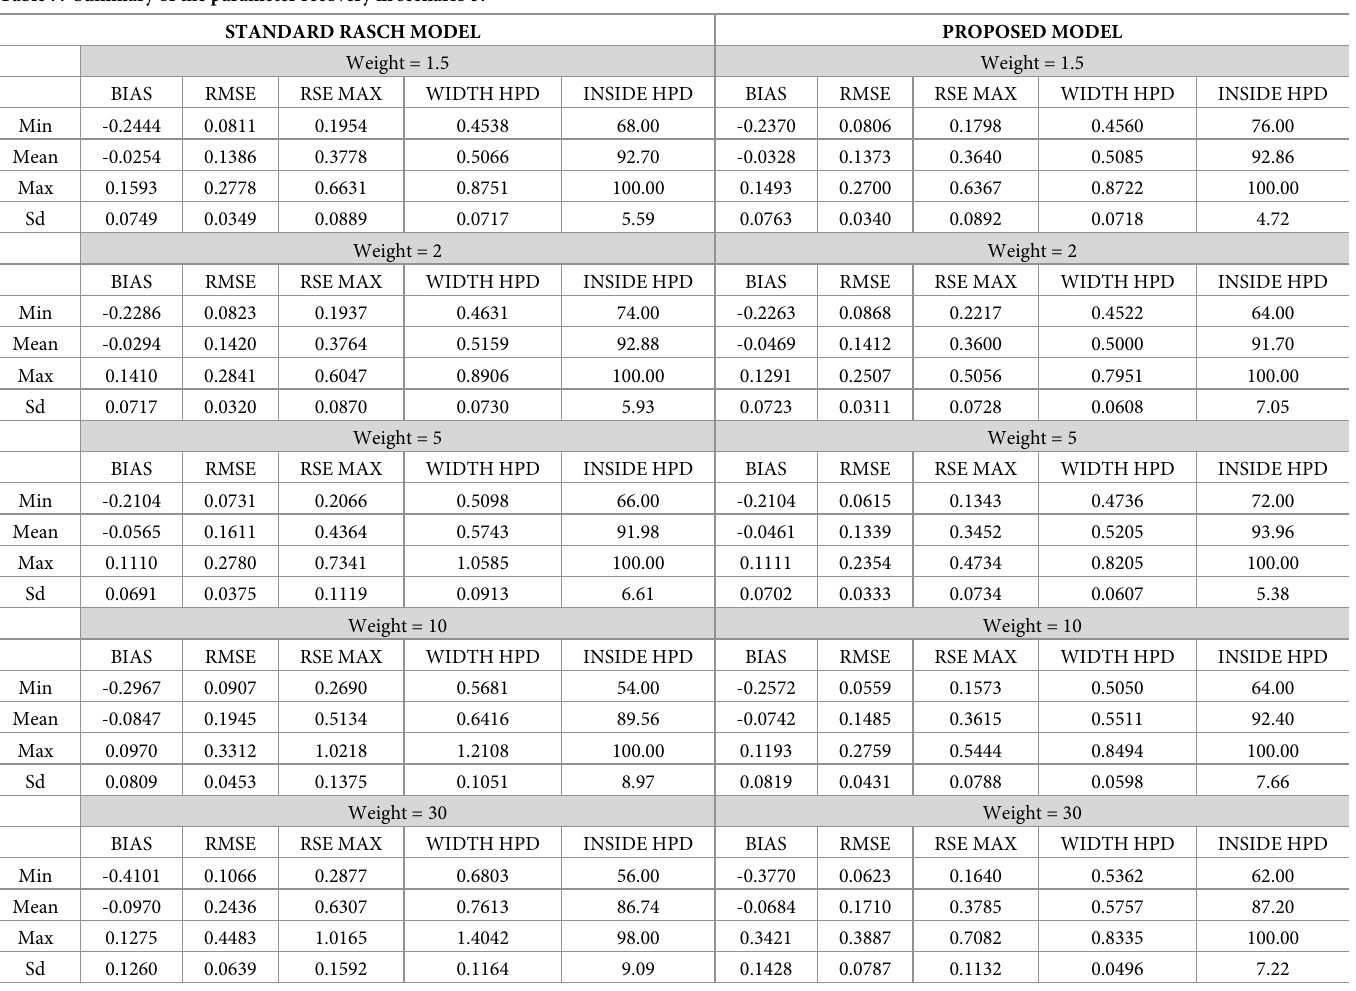
Table 7. Summary of the parameter recovery in scenario 3.